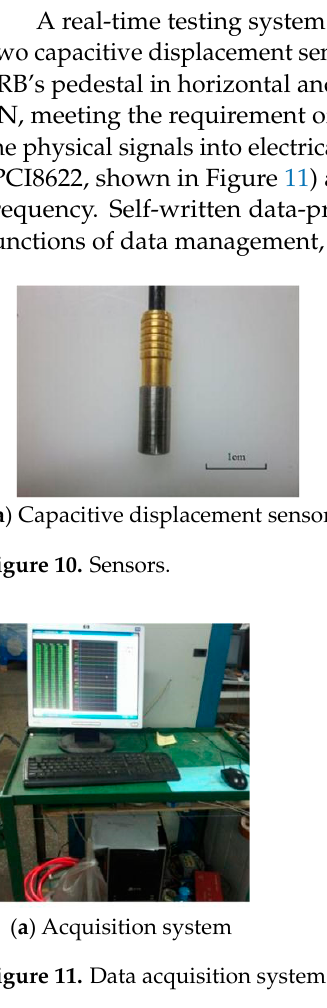
Figure 9. SRBs with different brands.